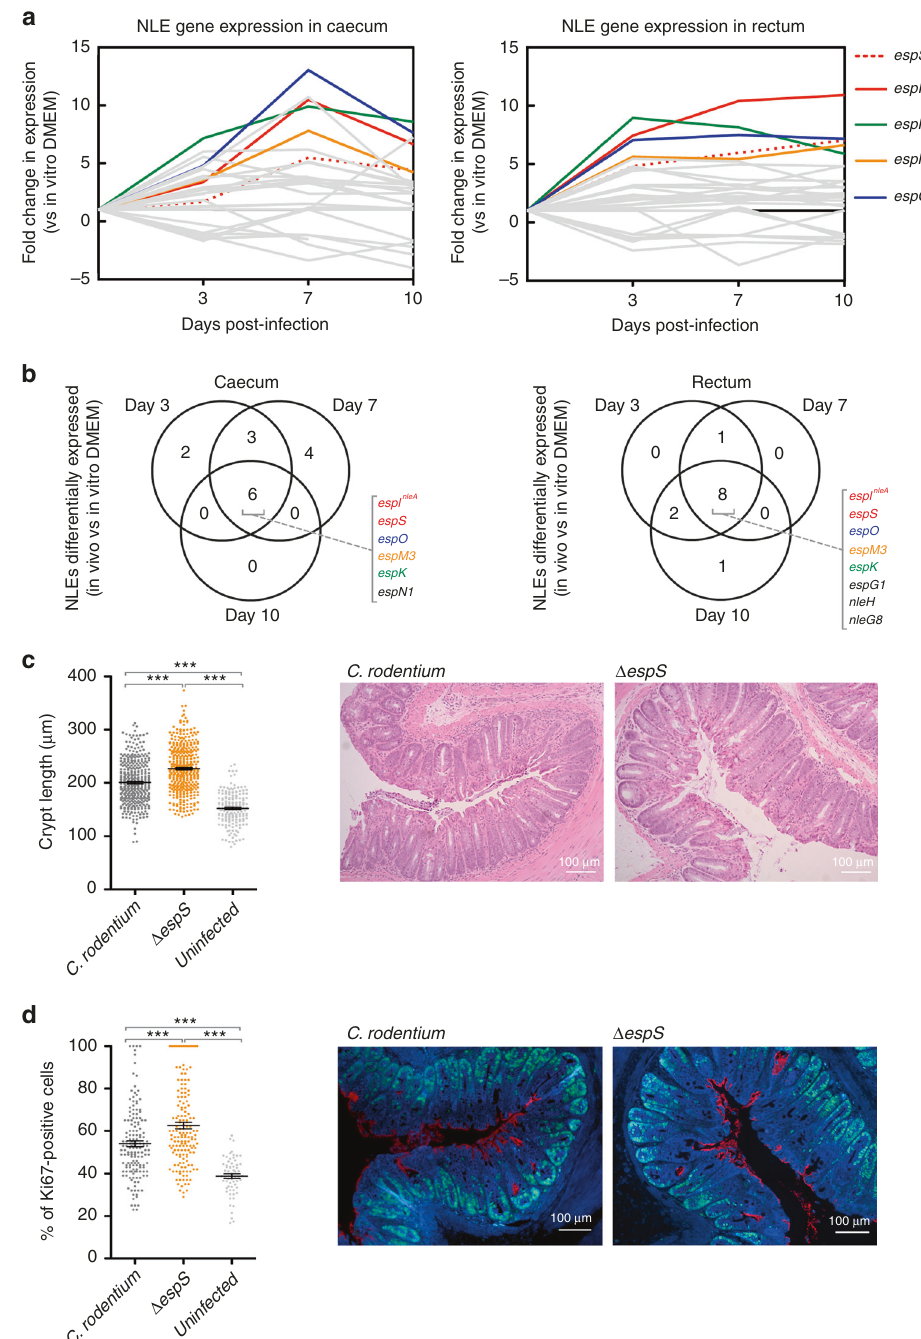
Fig. 3 Co-ordinated expression of the non-LEE-encoded effector repertoire in vivo. a Expression dynamics of the NLE repertoire in vivo compared to in vitro growth in DMEM. The line plots illustrate fold-change in expression at each site and time point during infection. A selection of NLEs ( espS, espI nleA , espO, espM3 and espK ) displaying the highest fold changes in expression are labelled and colour coded while remaining NLE genes are illustrated in grey. Gene expression data represents the mean of three replicates in all cases and full expression heatmaps are found in Supplementary Figure 4a. b Venn diagrams illustrating the overlap in NLEs differentially expressed throughout infection ( P ≤ 0.05; EDGE test). NLEs that were signi fi cantly differentially expressed in all in vivo samples are colour coded as in panel 3a. c Enumeration of colonic epithelial cell crypt length ( µ m) from mice (groups of n = 10; ± SEM) infected with either wild type C. rodentium , Δ espS or uninfected controls. Sampling was carried out at peak infection (day eight PI). Representative images of H&E- stained colon sections from wild type or Δ espS -infected mice are presented additionally. d Percentage measurement of epithelial proliferation in response to wild type or Δ espS infection by Ki-67 staining (±SEM). Representative images of stained colon sections from wild type or Δ espS -infected mice are presented. Markers used stained for C . rodentium (anti-Int280 β ; Cy3 red), Ki-67 (alexa-488 green) and host cells (DAPI blue). For all quanti fi cation, *** denotes P ≤ 0.0001 (one-way ANOVA with Bonferroni multiple correction test). Error bars represent standard error of the